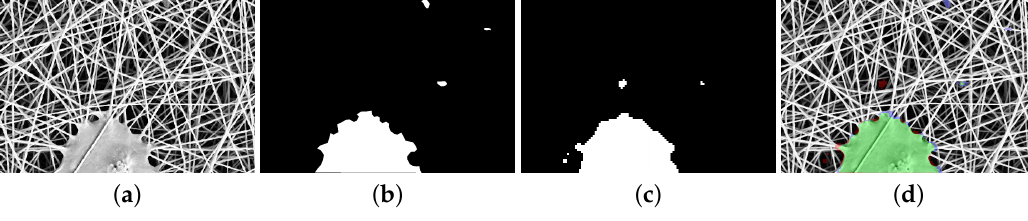
Figure 2. ( a ) the input image I ; ( b ) the binary mask of anomalies Ω I . White pixels represent anomalies; ( c ) estimated mask of anomalies (cid:102) Ω I . White pixels represent anomalies; ( d ) difference between Ω I and (cid:102) Ω I overlaid on the test image. Green pixels represent true positives , red pixels represent false positives , blue pixels represent false negatives , and no color pixels represent true negatives